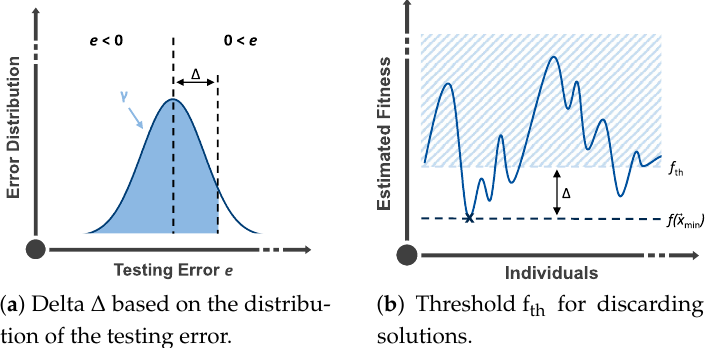
Figure 3. Representation of the delta based on the distribution of the testing error ( a ) as well as the resulting threshold ( b ) for the preselection of solutions by means of a